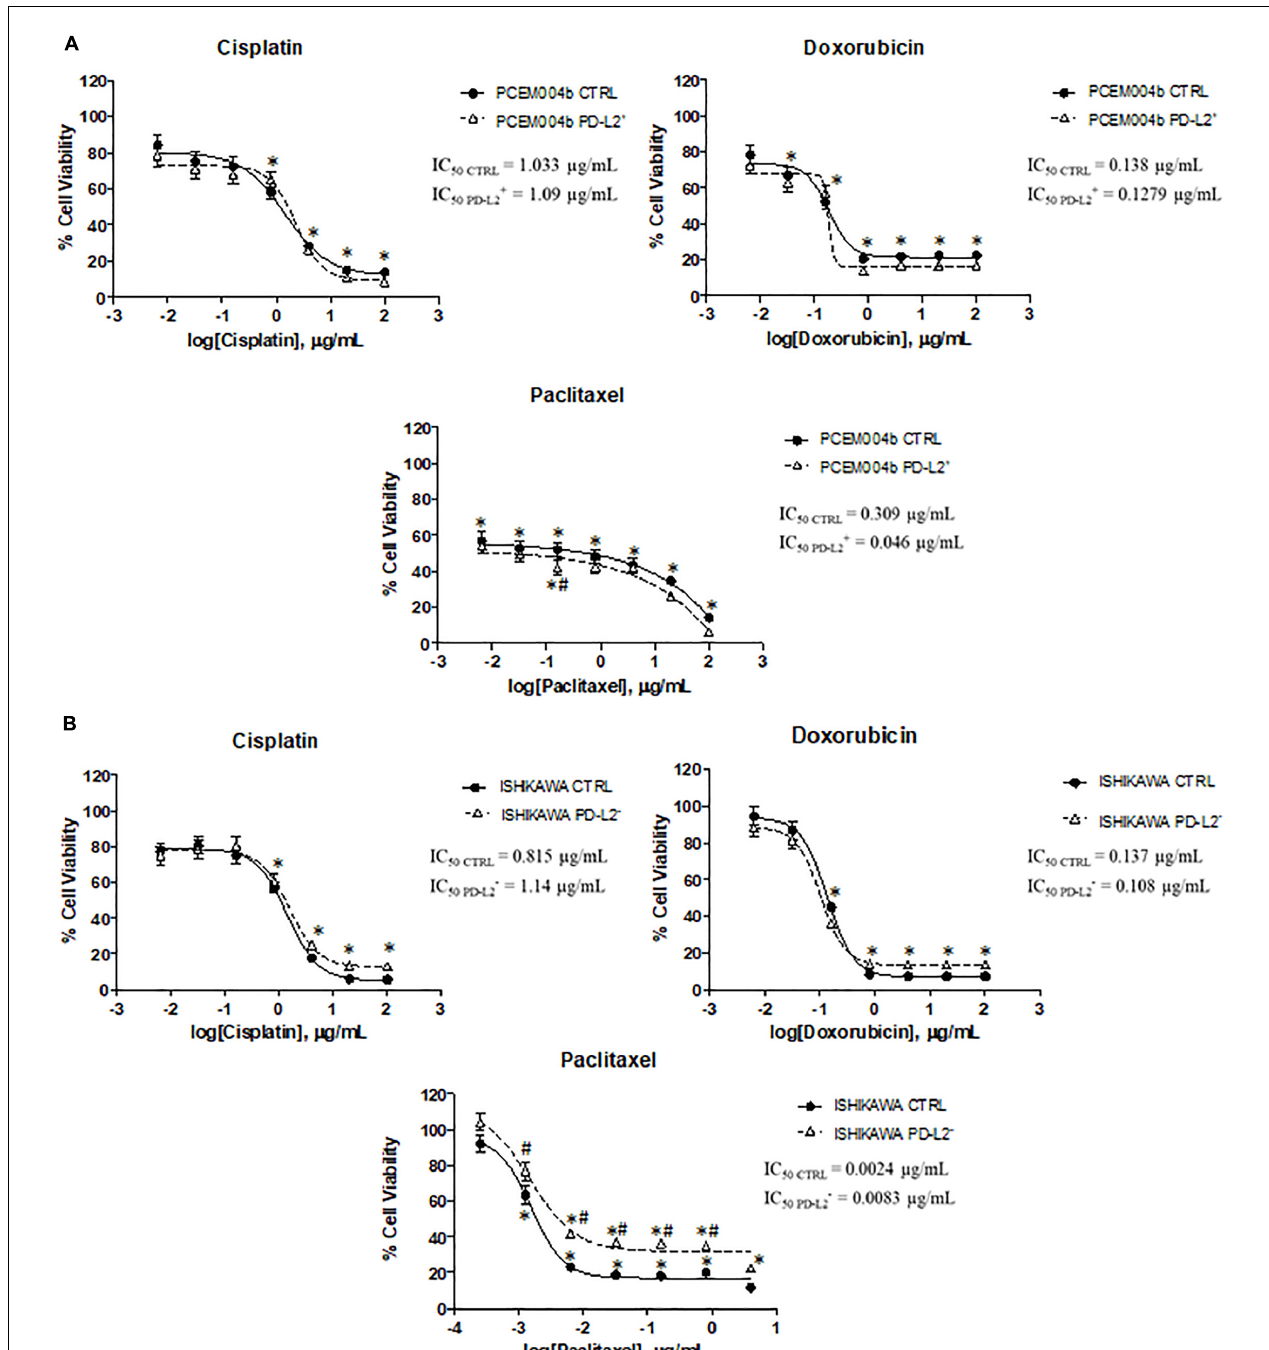
FIGURE 8 | PD-L2 influences chemoresistance in EC cell lines. (A) PD-L2 + and (B) PD-L2 − cell lines and relative controls were treated for 72 h with different concentrations of cisplatin, doxorubicin, and paclitaxel (up to 100 µ g/ml). Data shown are expressed as mean ± SE of three separate experiments. * p < 0.05 treated vs vehicle, # p < 0.05 PD-L2 + or PD-L2 − vs